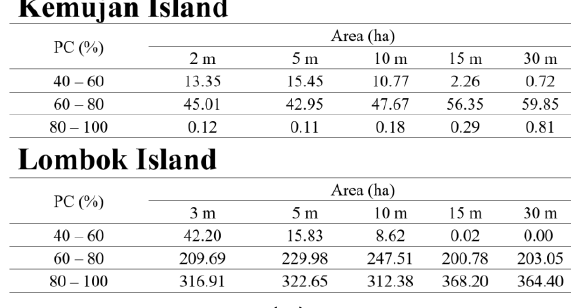
Table 2. Area measurement (ha) per seagrass percent cover at different spatial